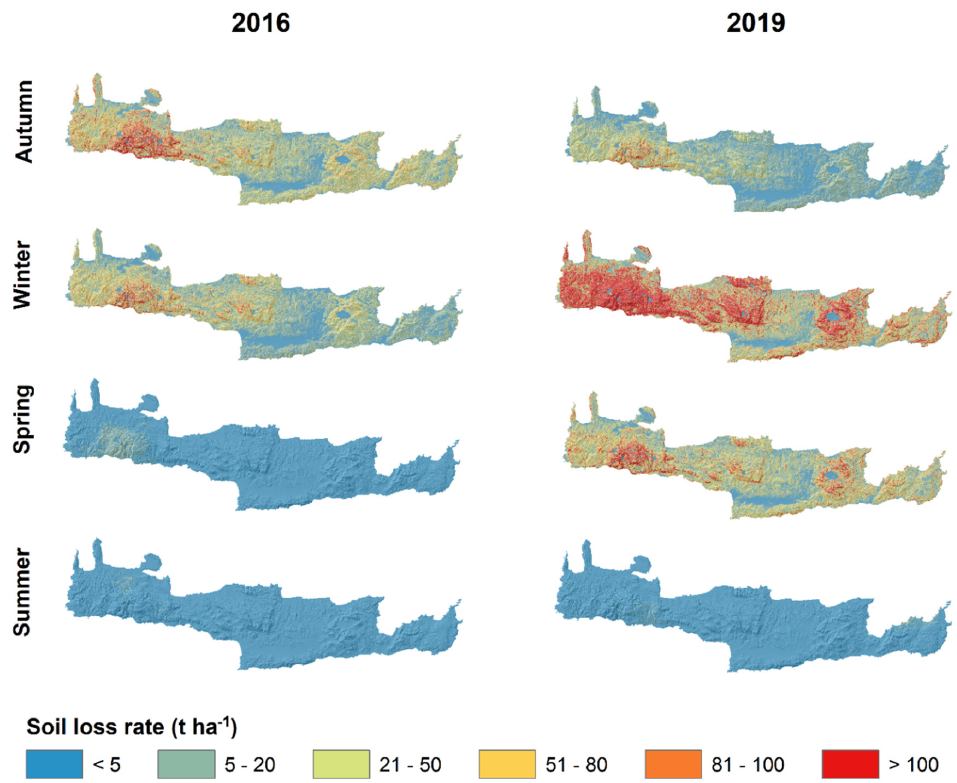
Figure 6. Seasonal spatial distribution of soil loss rate for Crete Island in 2016 and 2019.